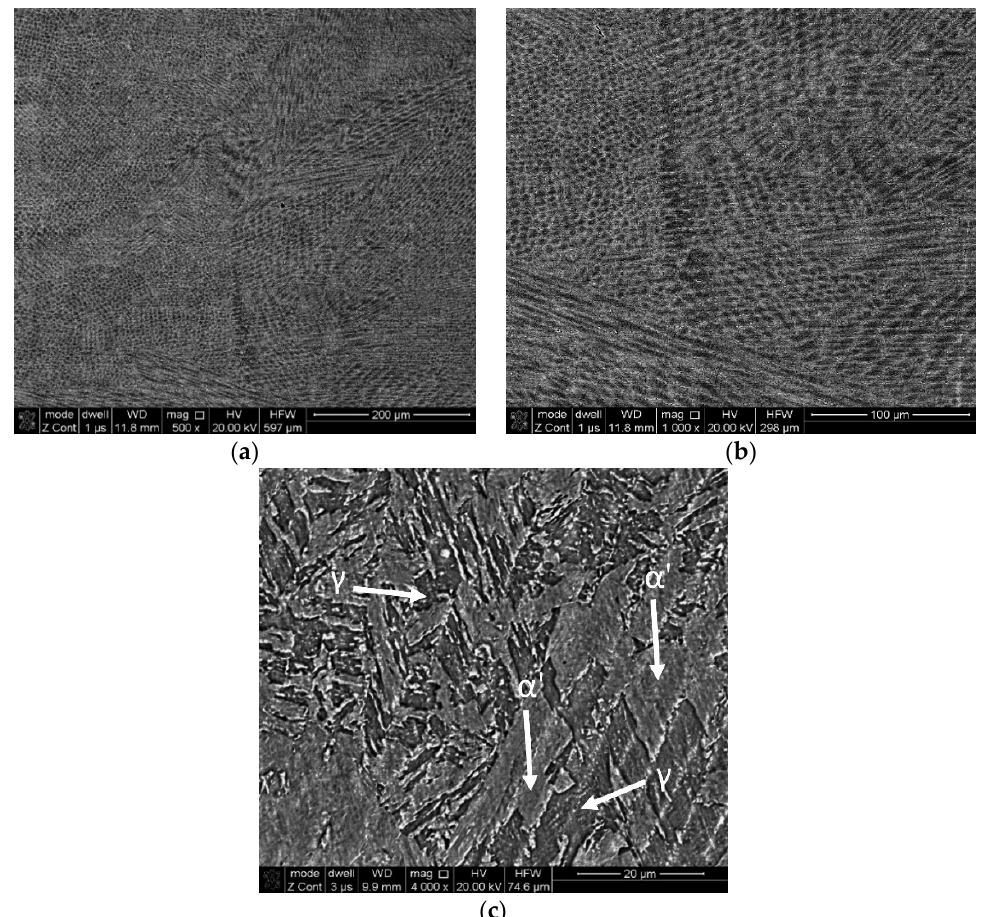
Figure 6. Scanning electron microscopy images of sample A (layer thickness—0.5 mm) at different magnifications (( a ) 200 µm scale, ( b ) 100 µm scale, ( c ) 20 µm scale).